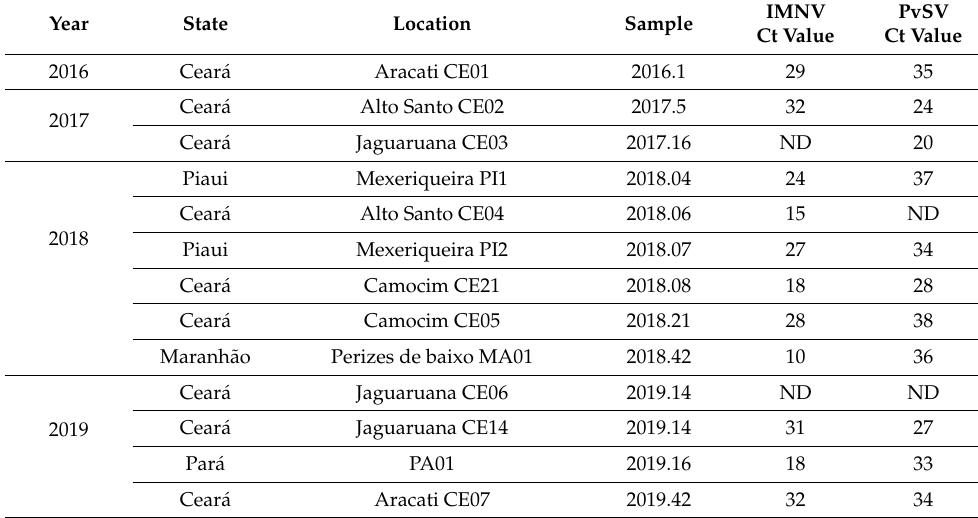
Table 3. Detection of IMNV and PvSV by real-time RT-PCR in Penaeus vannamei collected from shrimp farms experiencing disease outbreaks. These farms are located in four different States in Brazil. ND = Not